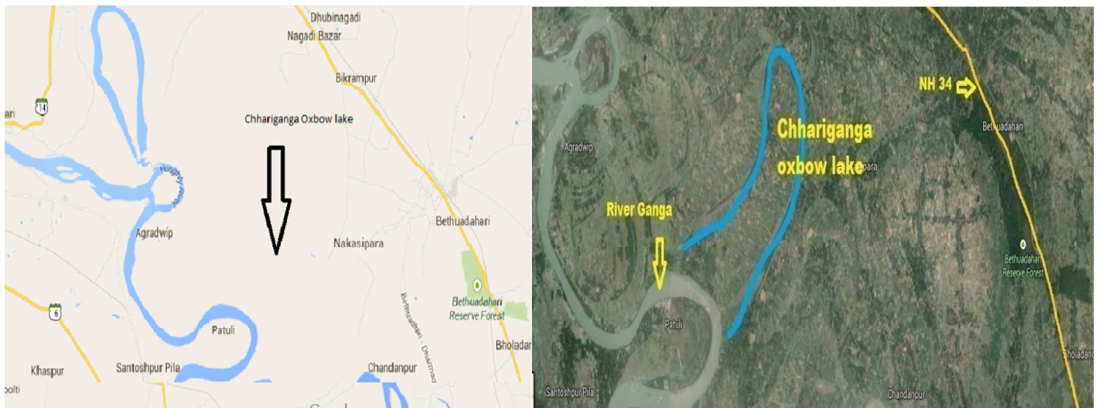
Figure 1. Map showing the study